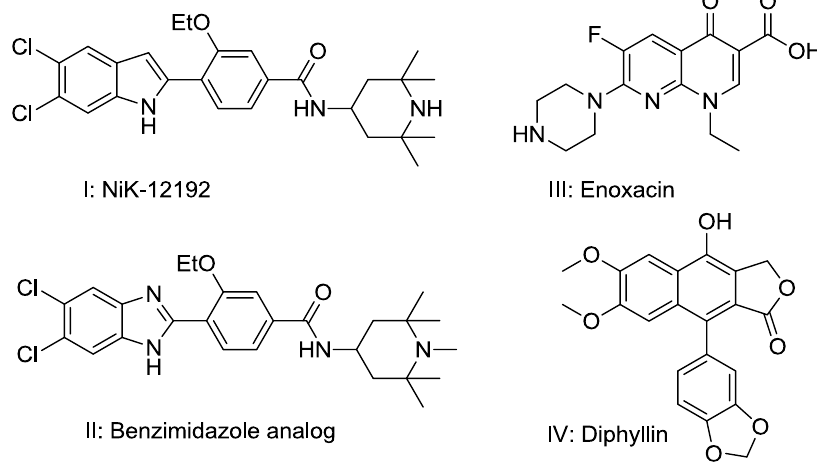
Figure 1. Structures of literature reported small molecule vacuolar (H + )-ATPase (V-ATPase) inhibitors.